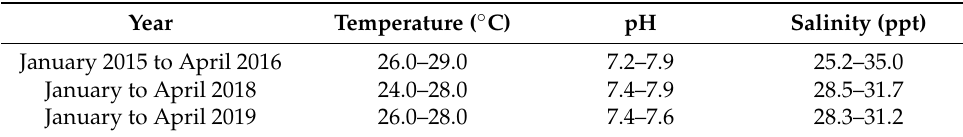
Table 1. Ranges of temperature, pH, and salinity values of seawater from juvenile green turtle holding tank at the Sea Turtle Conservation Center of Thailand (STCCT) during the periods 2015 to 2016, 2018, and